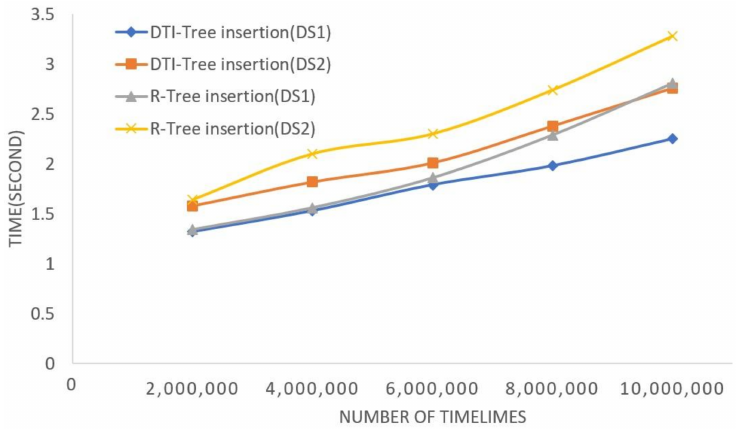
Figure 14. Insertion comparison.